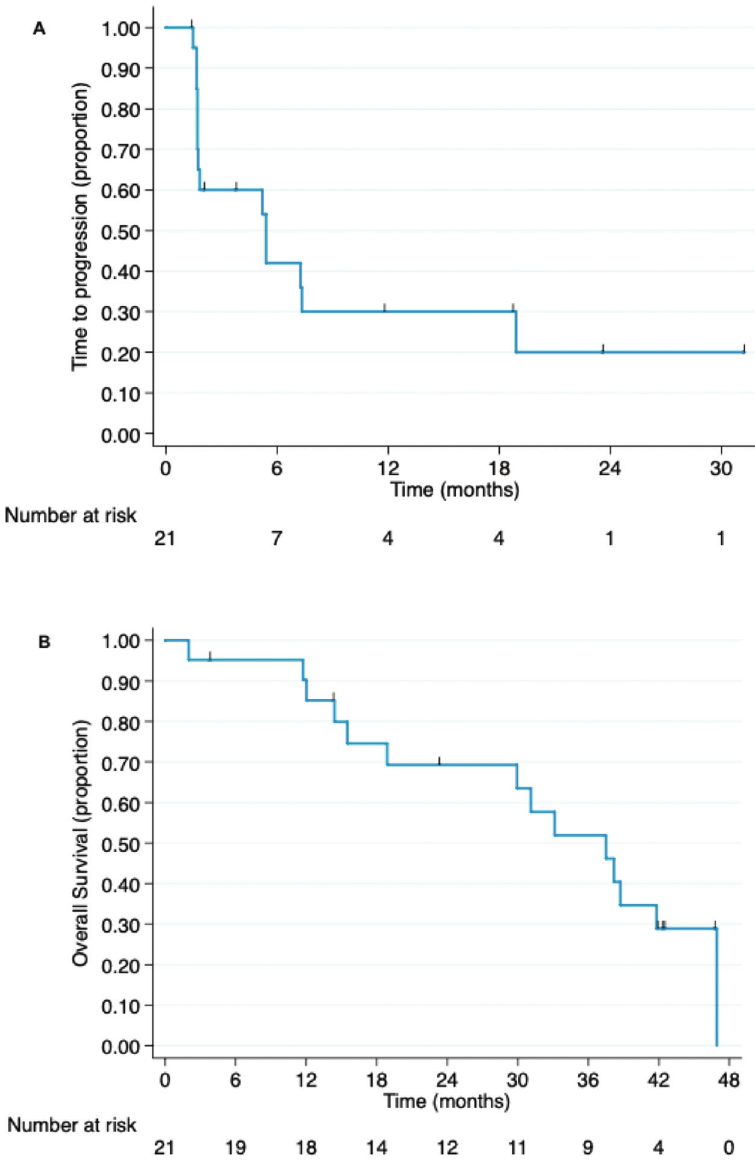
Figure 3 - Kaplan-Meier curves of (A) time to progression and (B) overall survival for patients with advanced hormone-receptor positive breast cancer who were administered anti-Lewis Y monoclonal antibody (hu3S193) (intention-to-treat